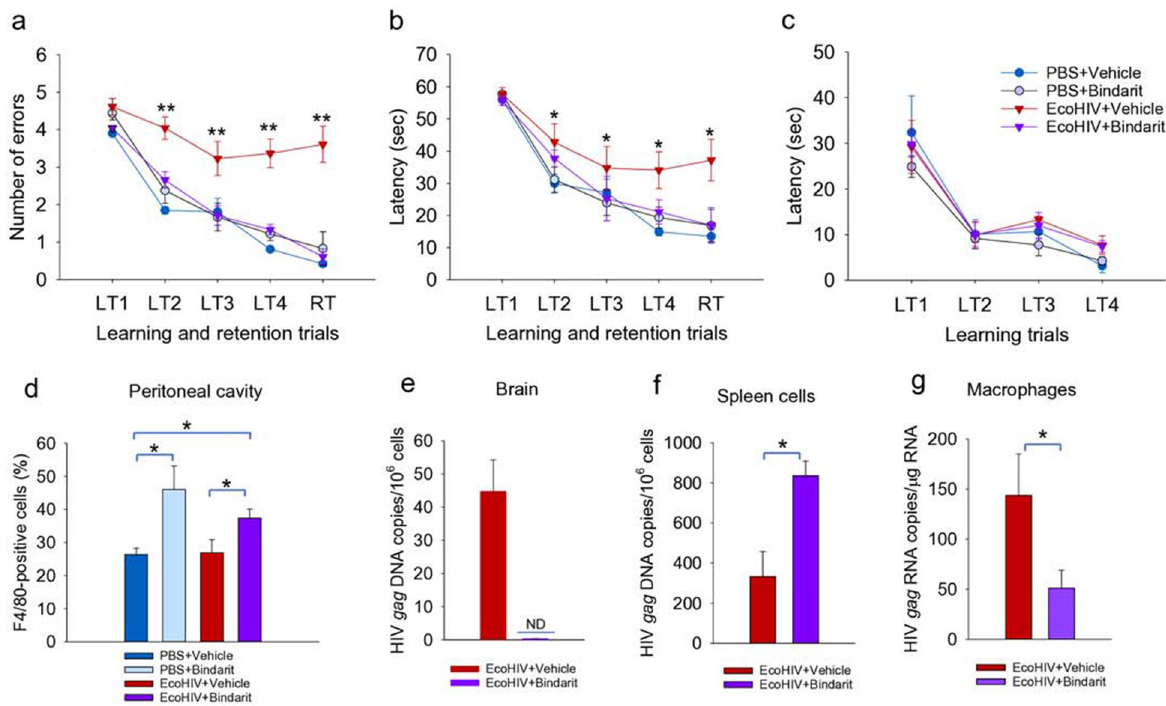
Figure 4. Pharmacological inhibition of CCL2 driven monocyte/macrophage migration in mice prevented EcoHIV induced memory defects. Male 6–8-week-old C57BL/6 mice were treated with the CCL2 synthesis inhibitor bindarit or placebo prior to and during EcoHIV infection. Learning and memory were measured using RAWM by counting ( a ) errors and ( b ) time to find the hidden platform or ( c ) time to find visible platform. RM ANOVA: ( a ) F(3,80) = 15.114, p < 0.001/LT2, F(3,80) = 21.837, p < 0.001/LT3, F(3,80) = 28.48, p < 0.001/LT4; ( b ) F(3,80) = 3.967, p < 0.001/LT2, F(3,80) = 7.463, p < 0.001/LT3, F(3,80) = 29.007, p < 0.001/LT4. For RT values, see text. Pairwise t-test, *p < 0.05 **p < 0.01 PBS vs. EcoHIV. ( d ) F4/80 positive macrophages were measured in the peritoneal cavity by flow cytometry. *p < 0.05 vehicle versus bindarit. ( e , f ) HIV gag DNA was measured in ( e ) brain and ( f ) spleen, or ( g ) HIV gag RNA was measured in peritoneal macrophages *p < 0.05 EcoHIV + vehicle vs. EcoHIV + bindarit. ND = not